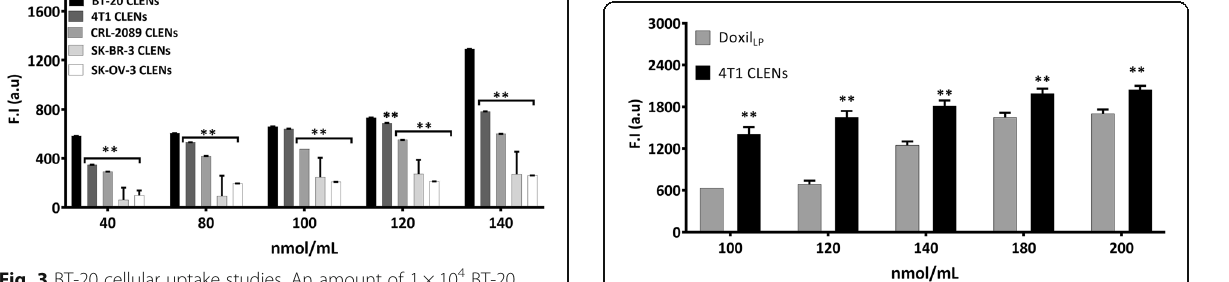
Fig. 5 Comparing cellular uptake of CLENs and Doxil LP . An amount of 1 × 10 4 4 T1 cells were seeded in a 48- well plate. After 24 h, cells were incubated for an additional 24 h with various concentrations of rhodamine labeled CLENs (containing 5 mol% of PEG- 5000 ) and Doxil LP . The data show that CLENs containing 5 mol% of DPPE-PEG- 5000 were taken up to a greater extent compared to the conventional Doxil LP . Error bars indicate mean ± S.D. ( n =